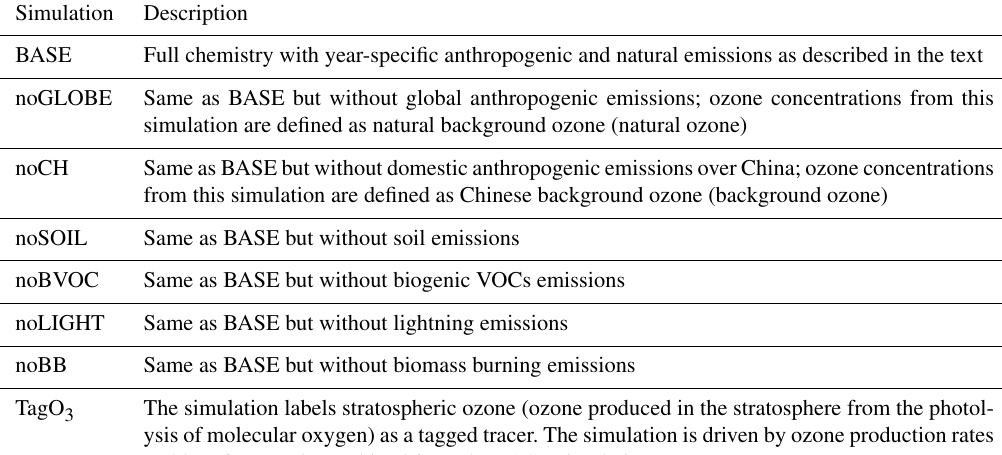
Table 3. Configurations of GEOS-Chem simulations in this study. Simulation Description BASE Full chemistry with year-specific anthropogenic and natural emissions as described in the text noGLOBE Same as BASE but without global anthropogenic emissions; ozone concentrations from this simulation are defined as natural background ozone (natural ozone) noCH Same as BASE but without domestic anthropogenic emissions over China; ozone concentrations from this simulation are defined as Chinese background ozone (background ozone) noSOIL Same as BASE but without soil emissions noBVOC Same as BASE but without biogenic VOCs emissions noLIGHT Same as BASE but without lightning emissions noBB Same as BASE but without biomass burning emissions TagO 3 The simulation labels stratospheric ozone (ozone produced in the stratosphere from the photol- ysis of molecular oxygen) as a tagged tracer. The simulation is driven by ozone production rates and loss frequencies archived from the BASE